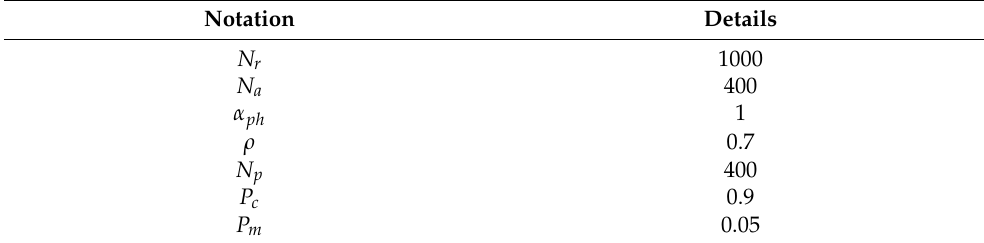
Table 3. Summary settings of key parameters for the